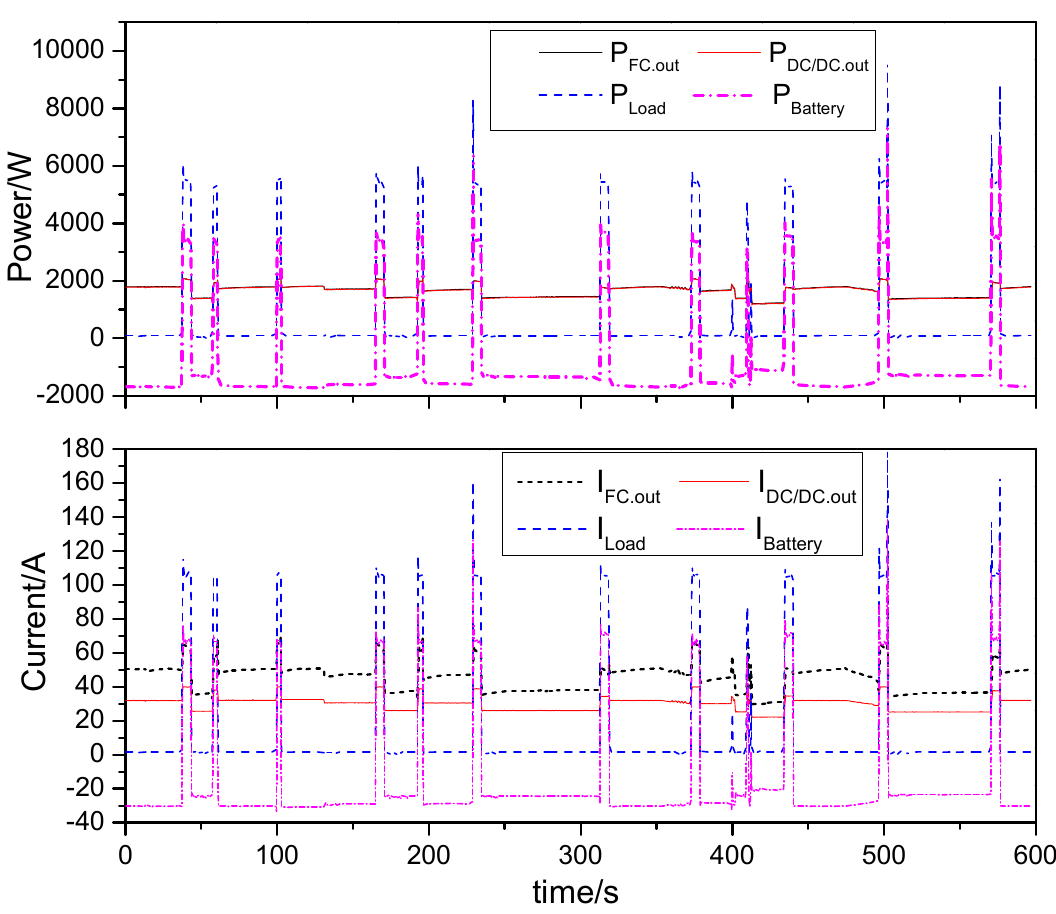
Figure 15. Response curve of the hybrid forklift while lifting.